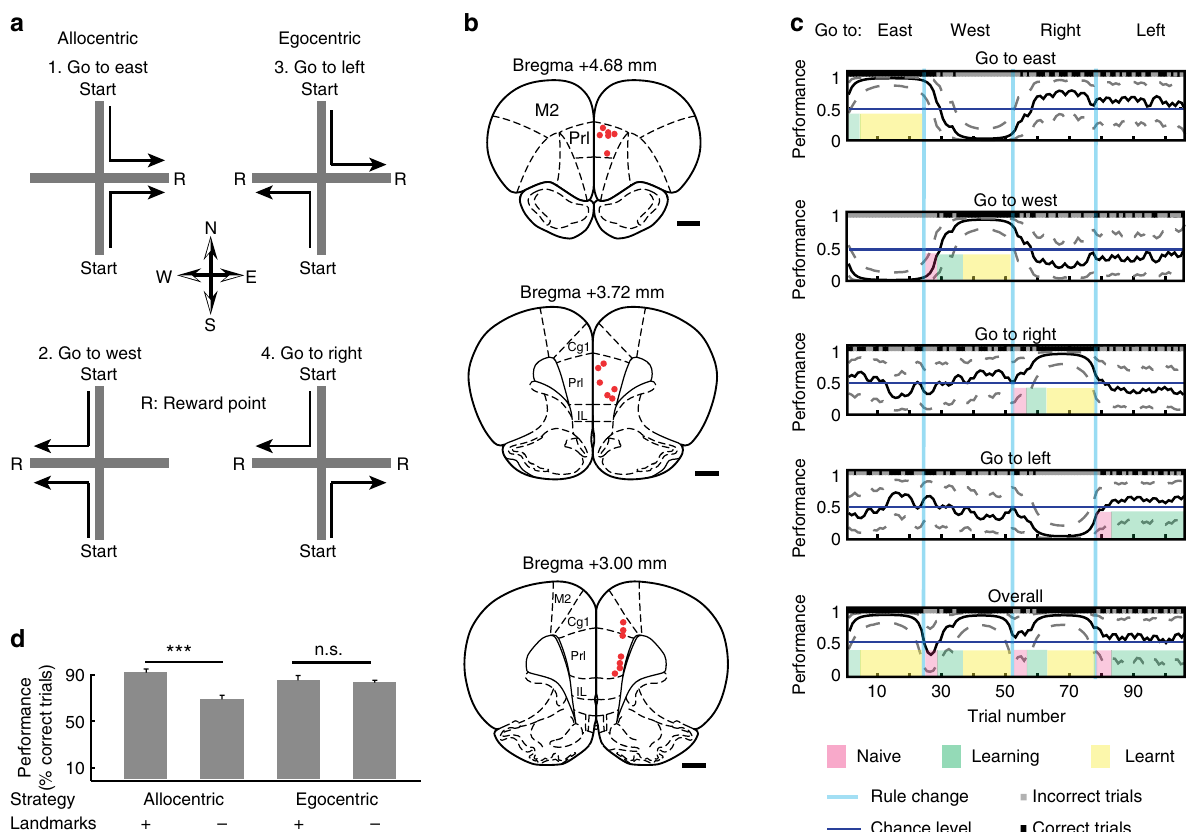
Fig. 1 Strategy-switching task and behavioural analysis. a Rats were placed randomly at one of the two possible start positions during consecutive trials. On the basis of landmark-referenced (allocentric strategy, rules: 1, 2) or self-referenced (egocentric strategy, rules: 3, 4) navigation, the animal has to travel on a plus-maze in order to receive reward (R). After the rat makes 13 correct choices within 15 consecutive trials, the rule is changed unannounced to the animal. b Position of the recording sites (n = 19, number of rats = 3) in the prelimbic and cingulate cortex indicated by red dots in three different coronal sections of the prefrontal cortex. Scale bars, 1 mm. c Task performance of a behavioural session was evaluated using the binary data of behavioural choices (correct choice: black, incorrect choice: grey) via a Markov-chain Monte – Carlo analysis 35 which provides a con fi dence interval for each trial. By thresholding the performance score of the lowest con fi dence interval in any of the learning curves (go east, go west, go to right or go to left) corresponding to different rules, three different behavioural phases were assigned to each trial: naive (below 0.1 for reversals and 0.3 for switches); learning (between 0.1 and 0.6 for reversals and 0.3 – 0.6 for switches); and learnt (over 0.6). d Task-performance during control experiments when landmarks on surrounding walls were removed or maintained during allocentric ( n = 11) or egocentric ( n = 13) strategies. Keeping the landmarks during allocentric strategies ( n = 12 tests; performance = 90 ± 3.015 %; data are mean ± SEM), removing the landmarks during allocentric strategies (n = 11, performance = 68 ± 3.71 %), keeping the landmarks during egocentric strategies (n = 12, performance = 83 ± 4.14 %) and removing the landmarks during egocentric strategies ( n = 13, performance = 81 ± 1.91%). Note that only the removal of landmarks during allocentric strategies resulted in a reduced task performance (Wilcoxon rank- sum test). *** indicates p < 0.001, N.S. indicates no signi fi cant. Error